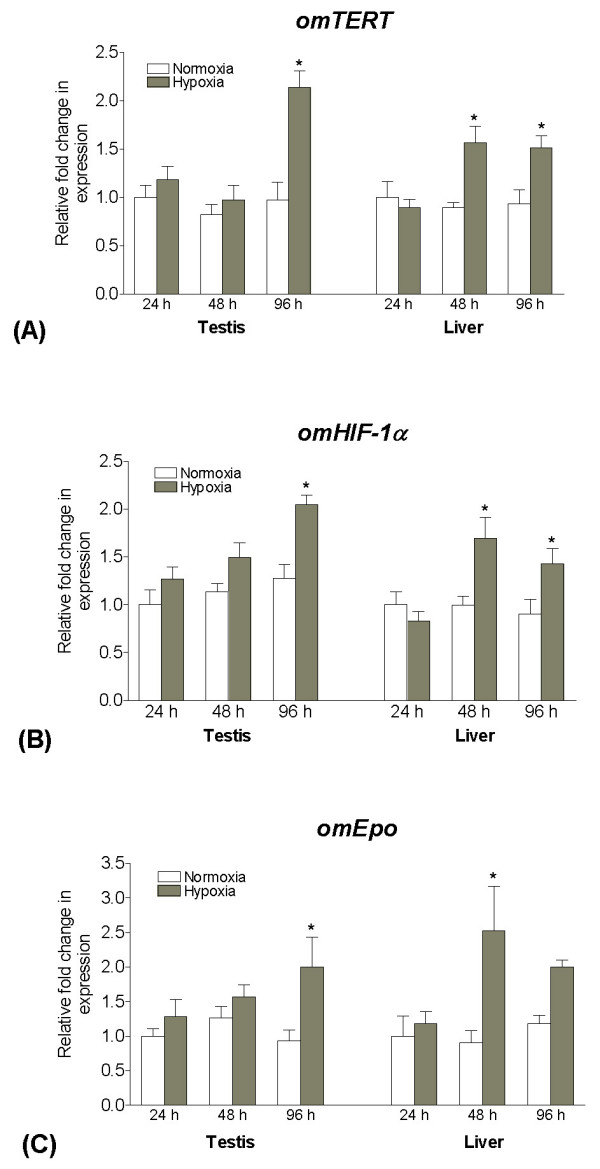
Hypoxic induction of omTERT, omHIF-1α and omEpo expressions in liver and testis of marine medaka in vivo. Male fish (n = 5) were exposed to either normoxic (6.4 mg O2 L-1) or hypoxic (1.8 mg O2 L-1) conditions for 24, 48 and 96 h. Expression of (A) omTERT, (B) omHIF-1α and (C) omEpo in the livers and testes was quantified using real-time RT-PCR and normalized with 18S rRNA. Data are presented as mean relative fold change ± SEM with respect to the gene expression level in the normoxic tissue sample at 24 h (arbitrarily set to 1). Asterisk (*) indicates significant difference from the other treatment group (p < 0.05).